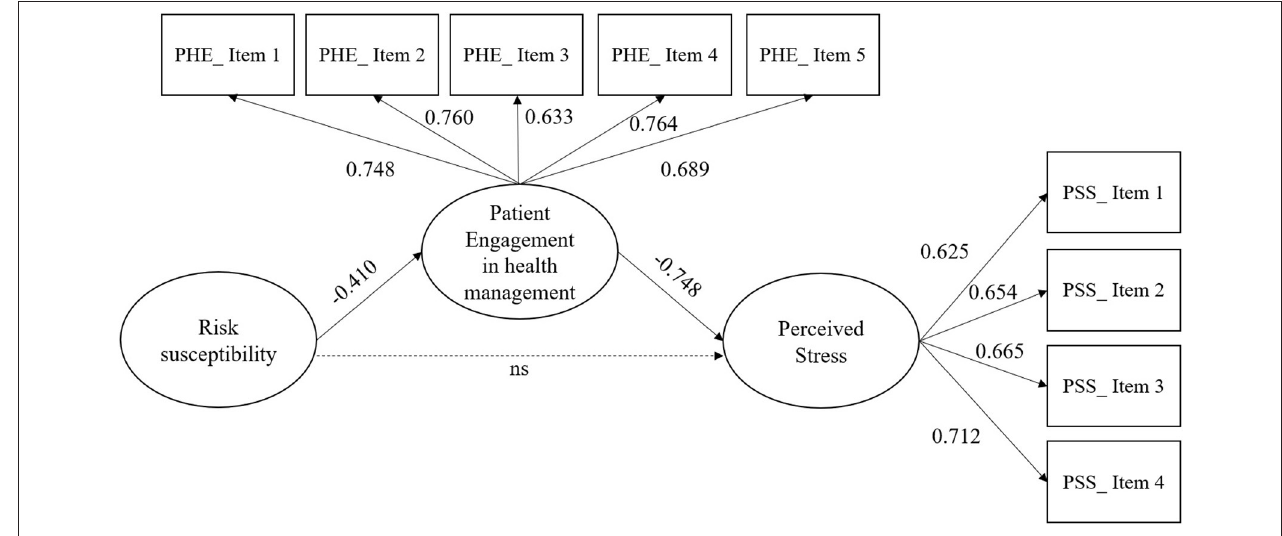
FIGURE 2 | The results of structural equation model (SEM). ns, not significant.